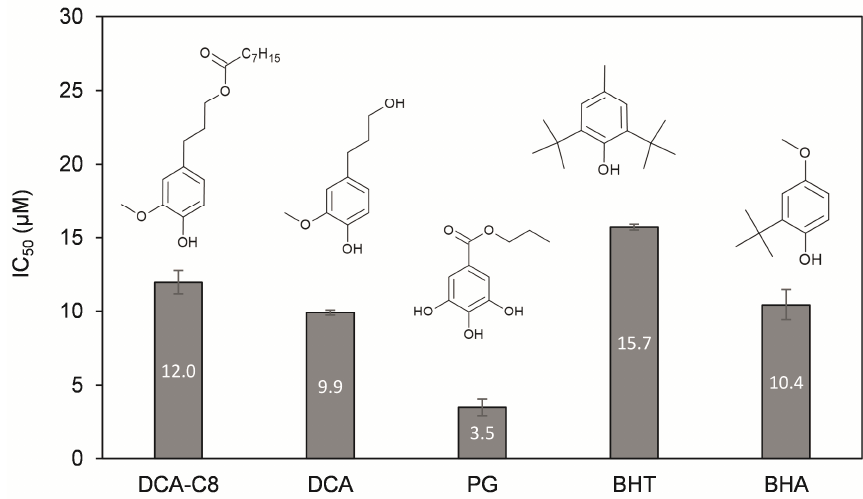
Figure 4. IC 50 values (90 min) of the ester product DCA-C8 compared to non-esterified DCA and other commercial antioxidants. DCA-C8 = dihydroconiferyl octanoate, DCA = dihydroconiferyl alcohol, PG = propyl gallate, BHT = butylated hydroxytoluene; BHA = butylated hydroxyanisole. Values shown are the average of three independent measurements ± standard deviation. IC 50 value refers to the concentration of the compound needed to scavenge 50% of the DPPH radical. A lower IC 50 value means a more potent antioxidant.